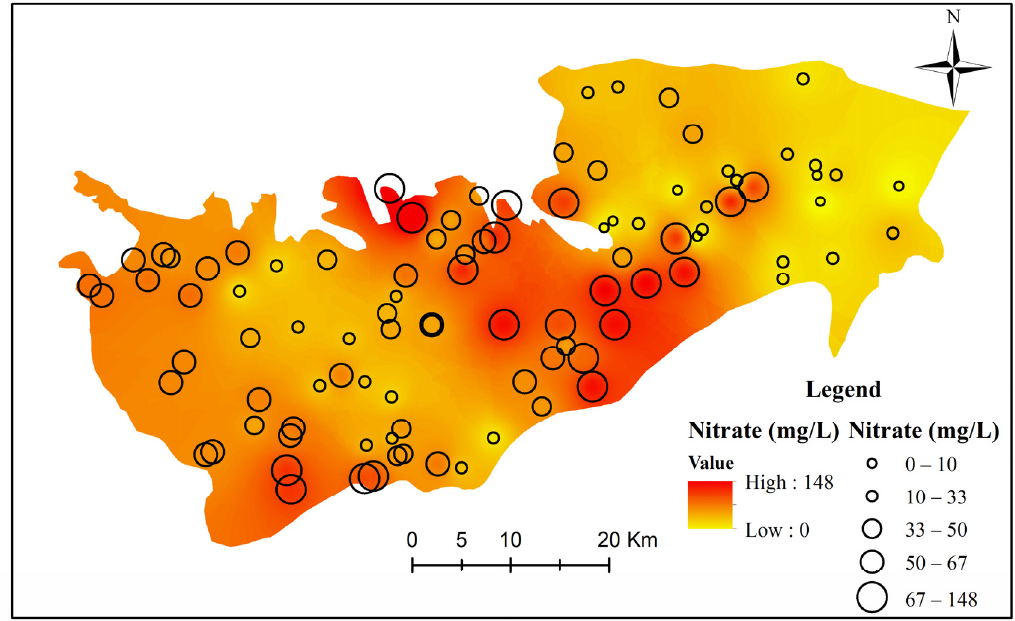
Figure 3. Spatial distribution of nitrate concentrations in the Saiss aquifer.